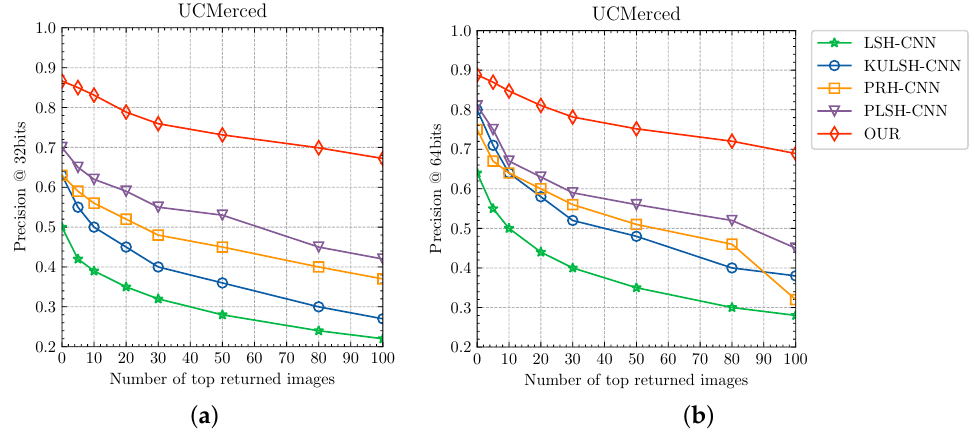
Figure 6. Precision curves with respect to a different number of retrieved images on the UCMD dataset. ( a ) Precision curve with regard to top-n@32 bits. ( b ) Precious curve with regard to top- n@64